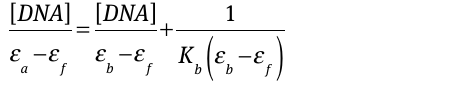
Figure 2: A view of Pb dashed